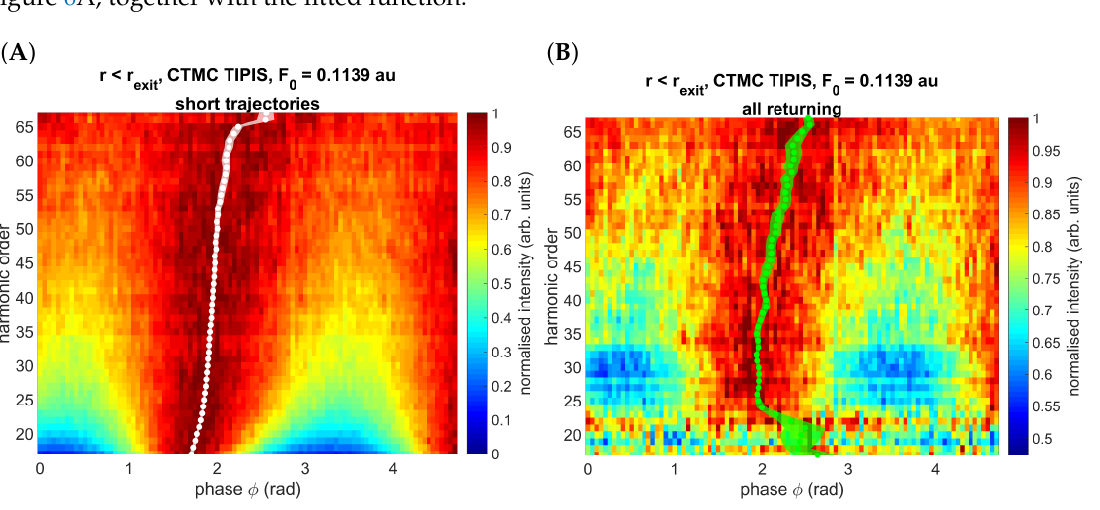
Figure 6. CTMC with Coulomb simulation, the two displacement gate plots show the influence of long trajectories. ( A ) only short trajectories with extracted ϕ max ( n ) shown in white; ( B ) both long and short trajectories are considered.